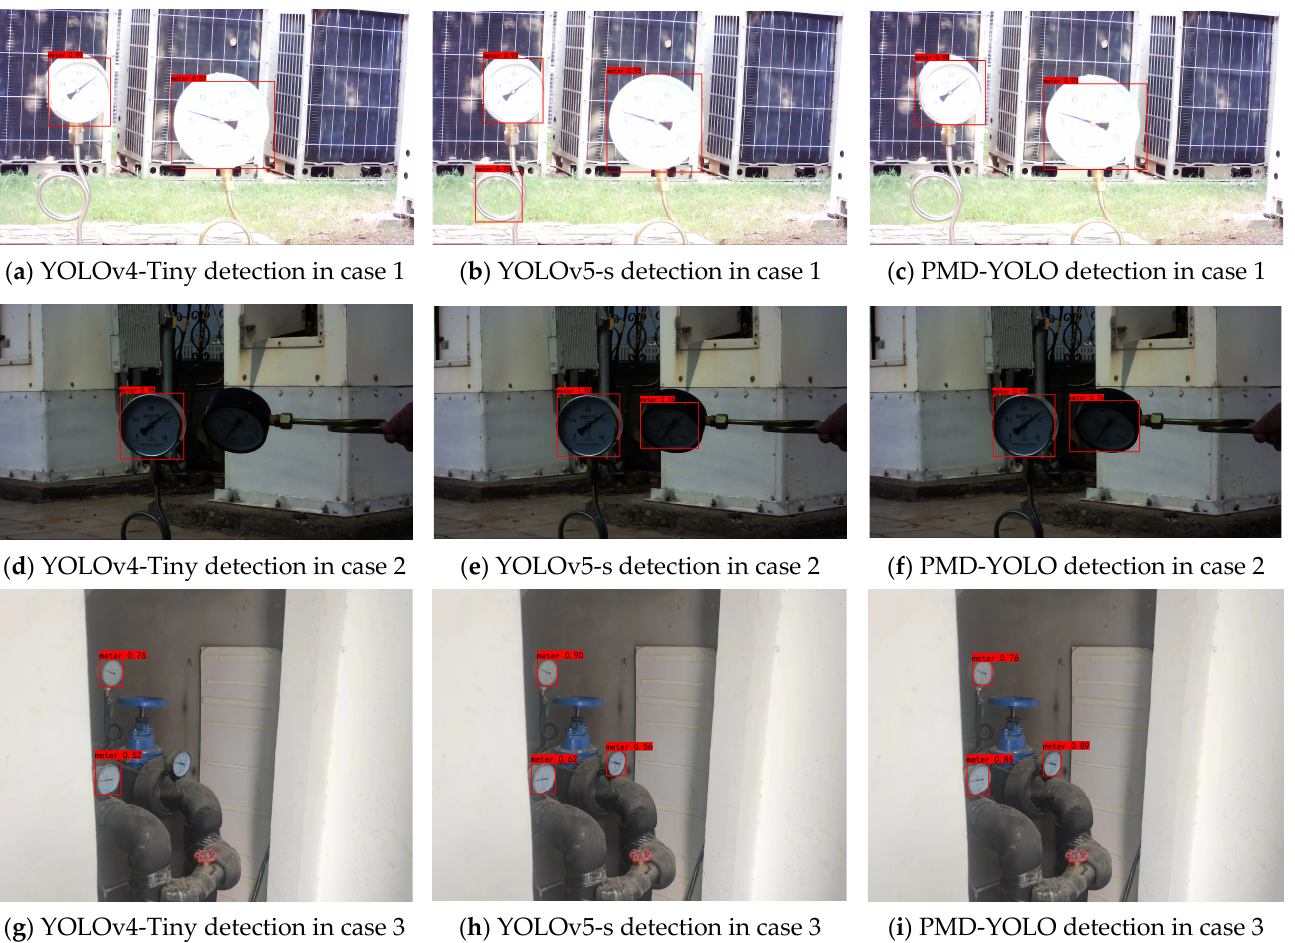
Figure 12. Comparison detection results of three models on pointer meter in different conditions; ( a – c ) are the results of overexposure shooting; ( d – f ) are the results of underexposed shooting; ( g – i ) are the results of oblique angle shooting. The object confidence scores in each graph are shown from left to right: ( a ) shows 0.99 and 0.87; ( b ) shows 0.75, 0.93, and 0.93; ( c ) shows 0.98 and 0.93; ( d ) shows 0.98; ( e ) shows 1.00 and 0.76; ( f ) shows 0.96 and 0.76; ( g ) shows 0.52 and 0.76; ( h ) shows 0.62, 0.90, and 0.56; ( i ) shows 0.86, 0.76, and 0.89.